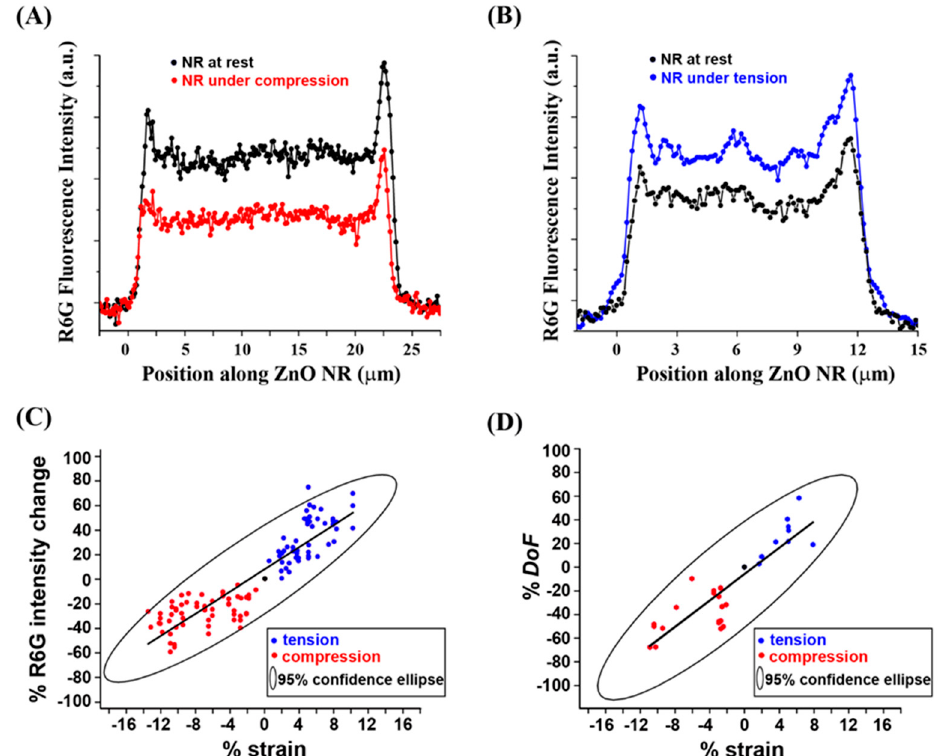
Figure 5. The change in DoF in % R6G fluorescence intensity was correlated to that of % strain by performing systematic measurements under a series of compression/tension and obtaining data from the end and middle positions on individual ZnO NRs. ( A , B ) The plots display R6G fluorescence intensity as a function of position along the same ZnO NR when the NR was under compression ( A ) and tension ( B ). Black, red, and blue data points correspond to the NR cases of neutral, compression, and tension, respectively. ( C ) The plot shows the relationship between the % strain compiled from compression to tension and the % R6G intensity values measured on both the end and middle positions of ZnO NRs. ( D ) The plot presents the compiled outcomes of the R6G fluorescence intensity measured in terms of % DoF with respect to the amounts of % compressive/tensile strain applied to individual ZnO NRs. The solid black line and circle in ( C , D ) are a linear fit through the data and the 95% confidence ellipse, respectively. The negative signs indicated on the tick labels of the graphs in ( C , D ) simply refer to the measurement case of compression.